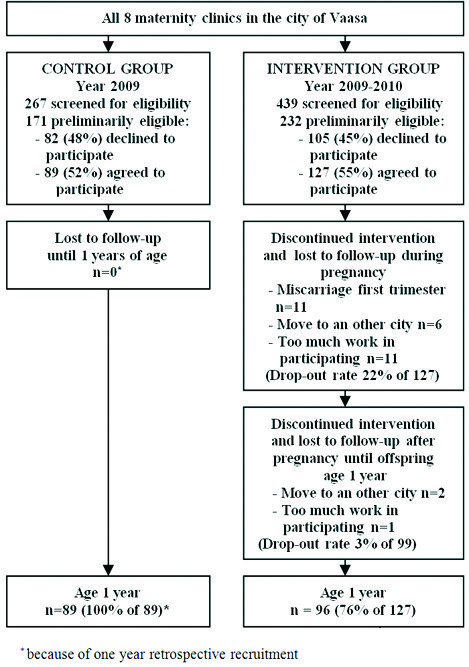
Flow chart of the study. *Because of one year retrospective recruitment.